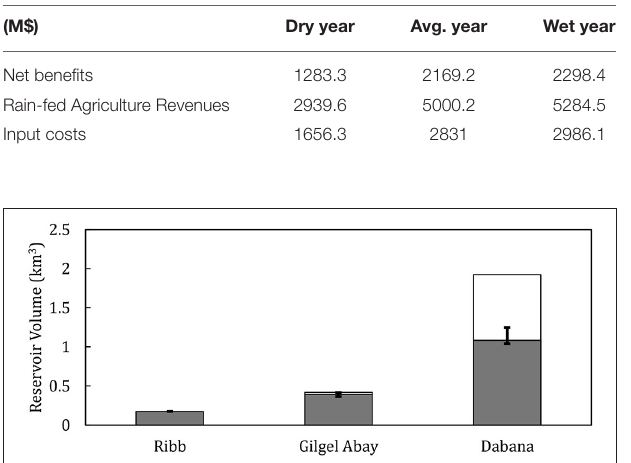
FIGURE 6 | The model reservoir capacity compared to the master plan (the red error bar shows the model built reservoir capacities for the dry and wet years).